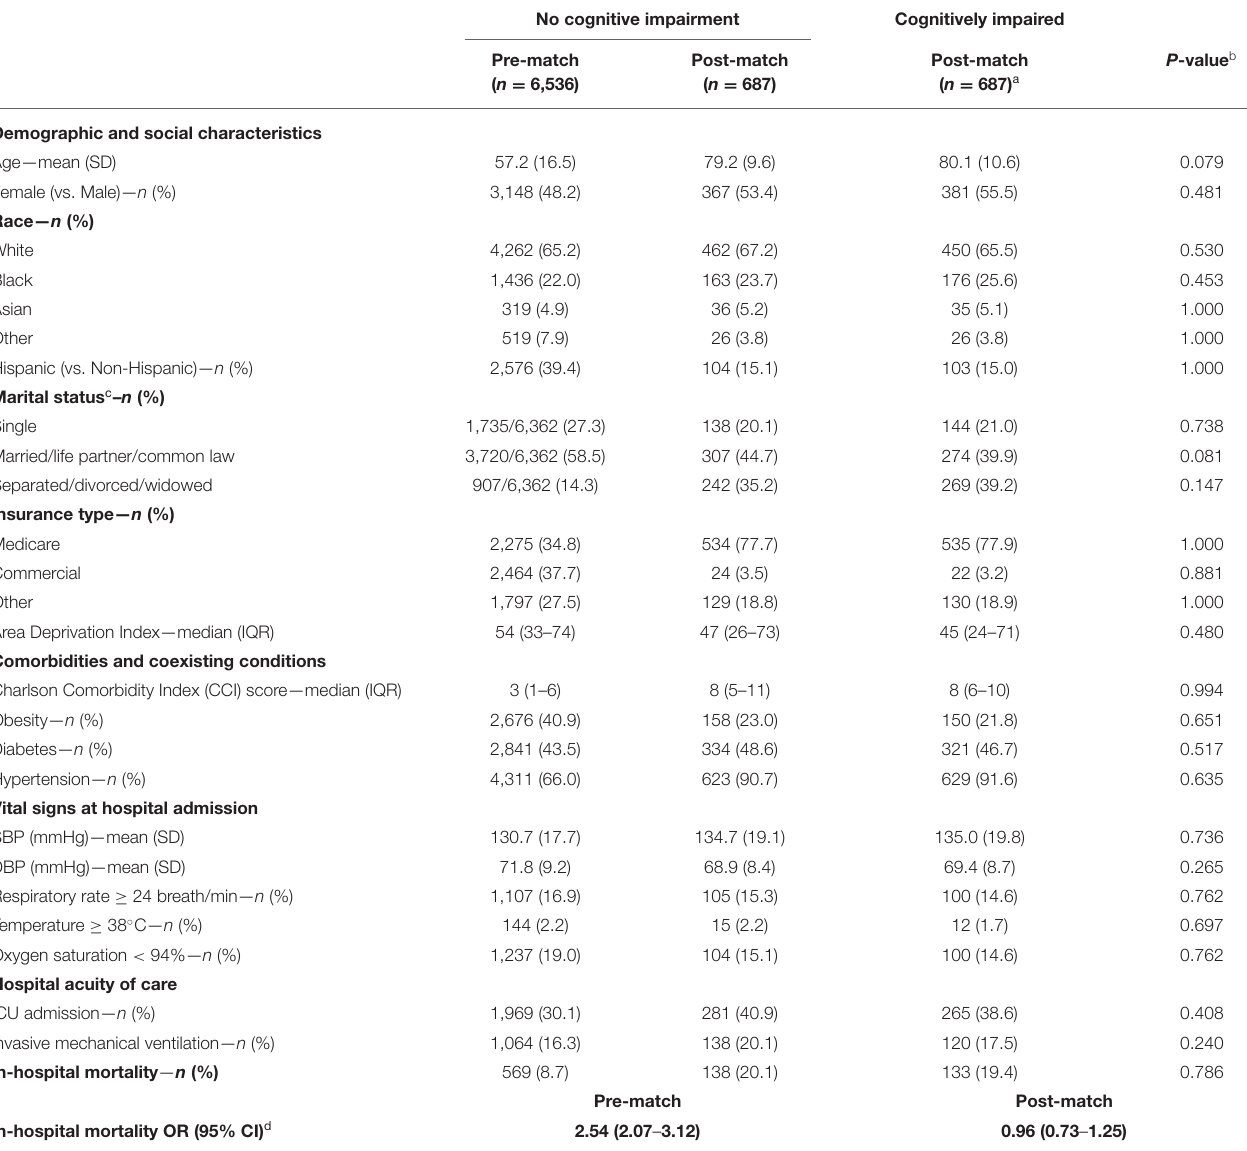
TABLE 2 | Pre- and post-propensity score matched characteristics of adults hospitalized with COVID-19 at Houston Methodist through December 11th, 2020, by cognitive impairment